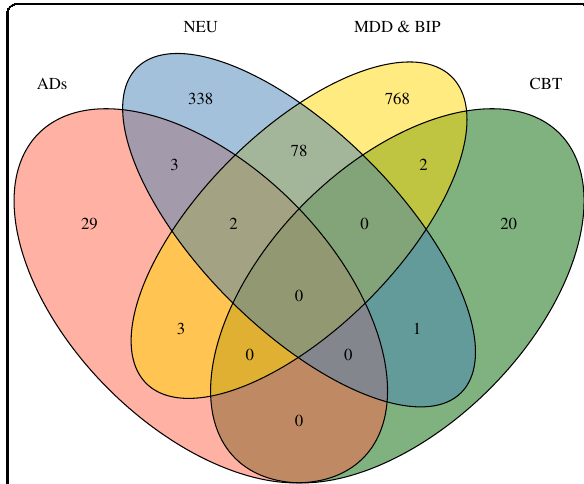
Fig. 1 Venn diagram of the genes related to ADs, CBT, MDD & BIP, and NEU. Number in area shows the gene number in corresponding overlap. We note that ADs share few genes with MDD & BIP and NEU, and no genes with